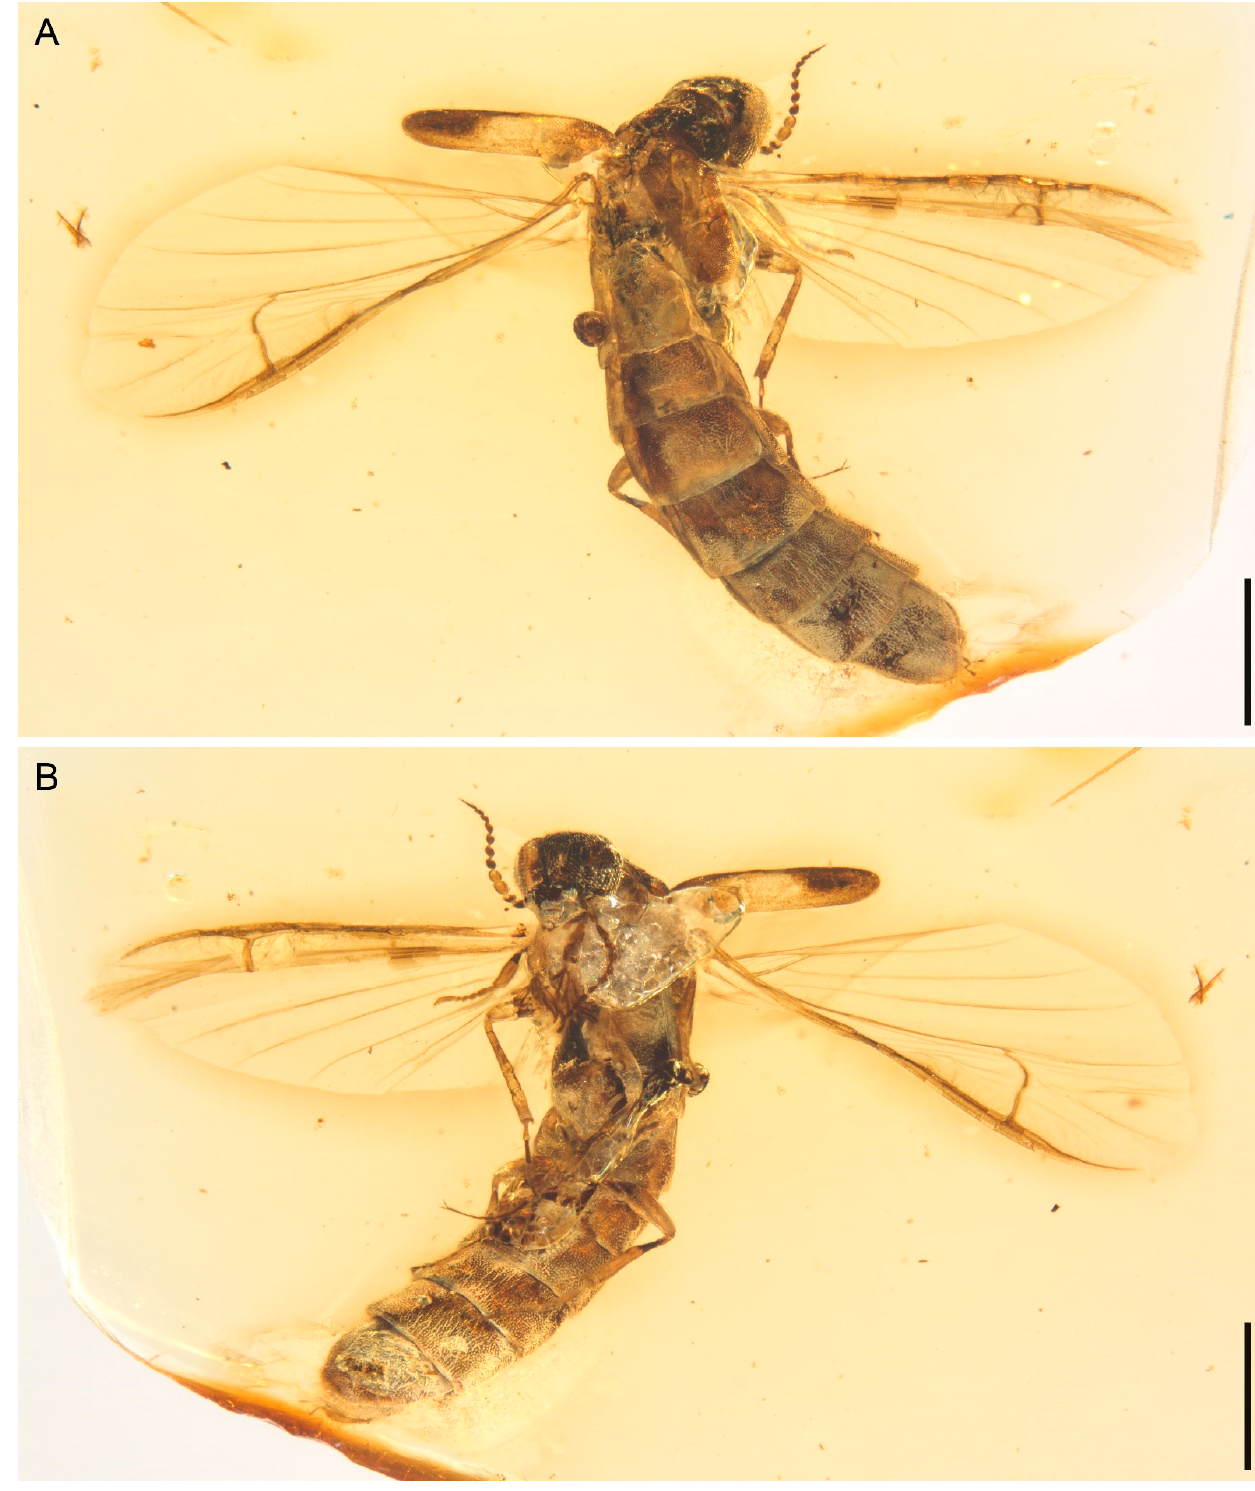
Figure 1. General habitus of Cretoquadratus fossilis (Yamamoto) comb. nov. , NIGP180657, under incident light. ( A ) Dorsal view. ( B ) Ventral view. Scale bars: 1 mm.